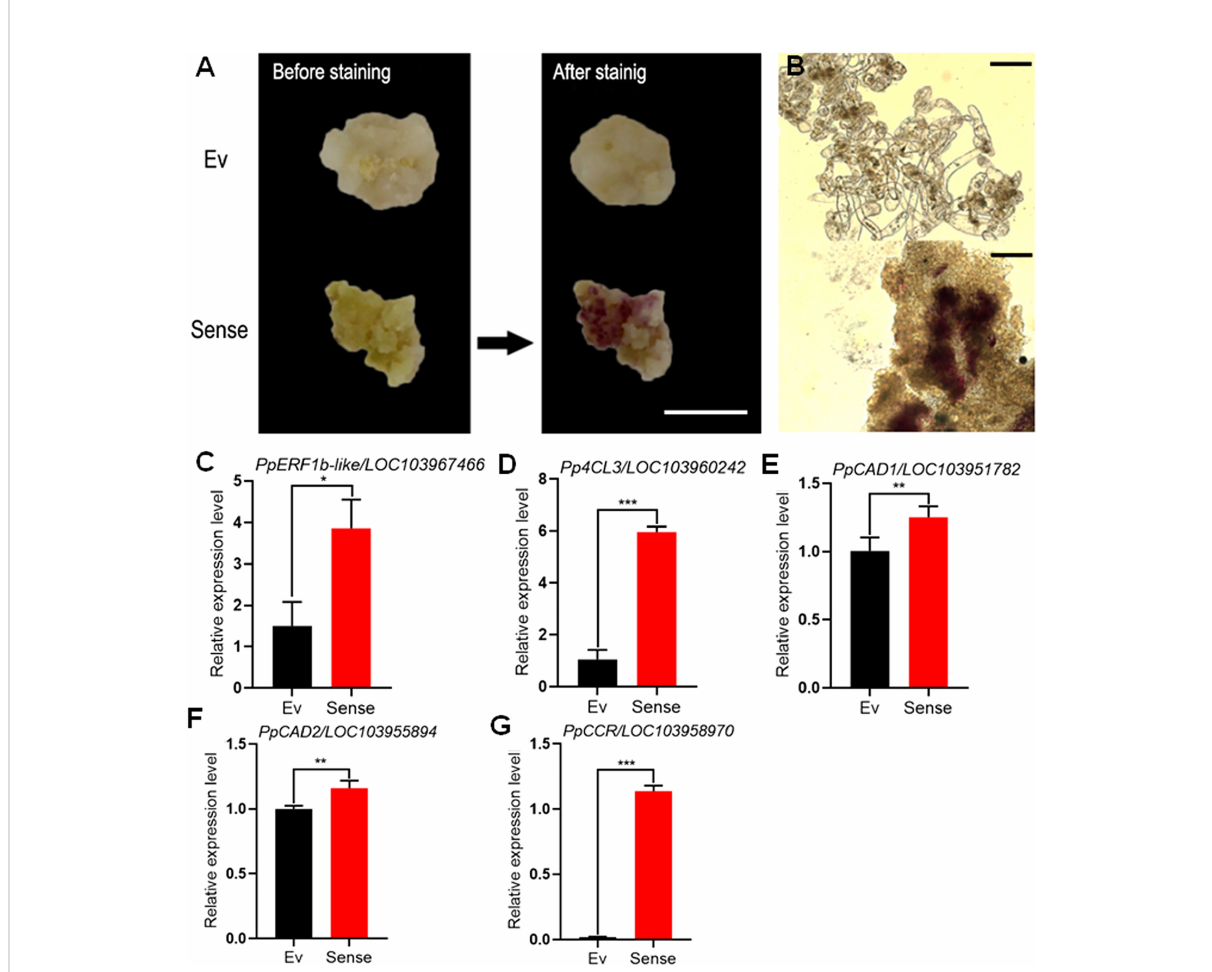
FIGURE 6 Genetic transformation of callus. (A) Whole tissue lignin staining. Scale bar = 100 m m. Ev: Empty vector, Sense: sense- PpERF1b-like . (B) Lignin staining of thin-sections of pear. Scale bars = 50 m m. (C) The relative expression level of PpERF1b-like in transgenic callus. Data are given as mean ± SD (n = 4). The asterisk represents a signi fi cant difference (* p < 0.05; ** p < 0.01; Student ’ s t-test ). (D – G) The relative expression levels of lignin biosynthesis related genes ( Pp4CL3 , PpCAD1 , PpCAD2 , PpCCR ) in transgenic calli. Data are given as mean ± SD (n = 4). The asterisk represents a signi fi cant difference (* p < 0.05; ** p < 0.01; *** p < 0.001; Student ’ s t-test ). Ev: Empty vector, Sense: sense- PpERF1b-like